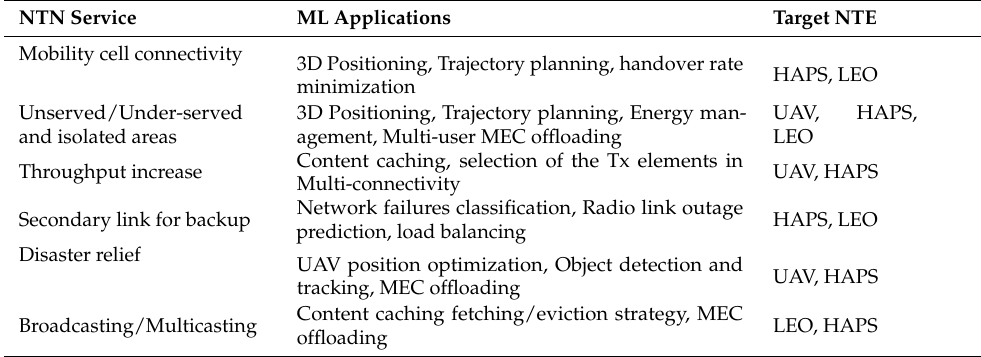
Table 4. ML applications for NTN